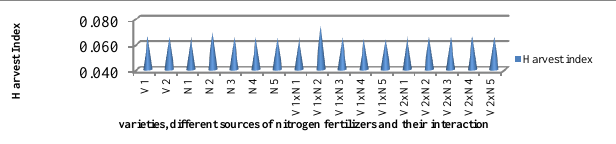
Figure 3: Effect of varieties, different sources of nitrogen fertilizers and their interaction on Harvest index of baby corn (V 1 = BARI sweet corn-1, V 2 = Baby star, N 1 = (100% urea – N), N 2 = (75% urea – N + 25% CD – N), N3= (50% urea – N + 50% CD – N), N 4 = (75% urea – N + 25% PM – N), N 5 = (50% urea – N + 50% PM – N).